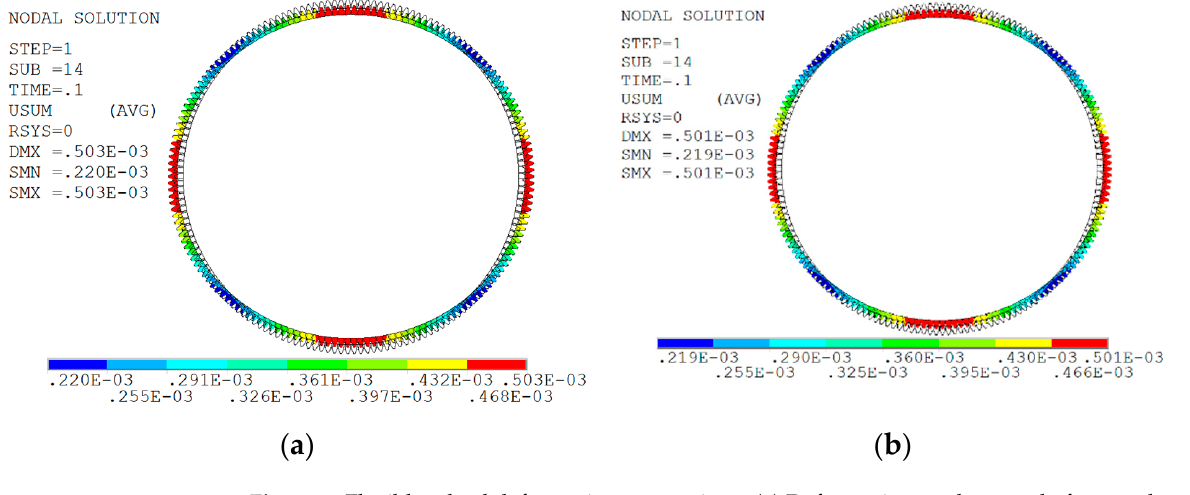
Figure 5. Flexible wheel deformation comparison. ( a ) Deformation nephogram before tooth profile mesh simplification. ( b ) Deformation nephogram after tooth profile mesh simplification.